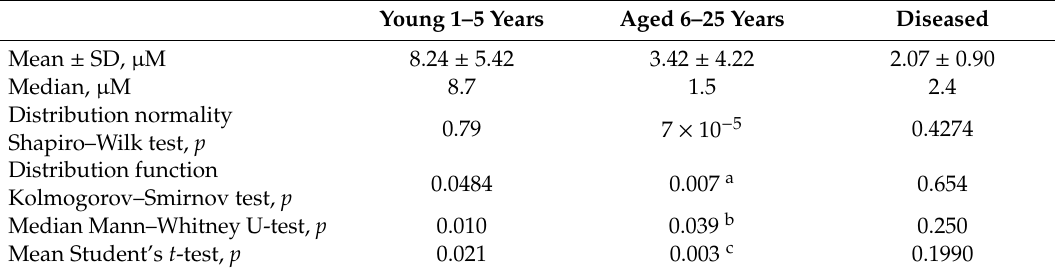
Figure 3. EPR spectra of MGD complex with iron (2 + ) and nitric oxide MNIC MGD-FeNO in the